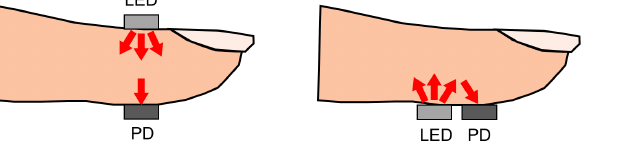
Figure 6. Schematic overview of transmissive ( left ) and reflective ( right ) PPG using an LED and a photodetector (PD). For the transmissive PPG, LED and PD are placed on opposite sides of the finger. For reflective PPG, the LED and PD are placed on the same side. Figure reproduced from